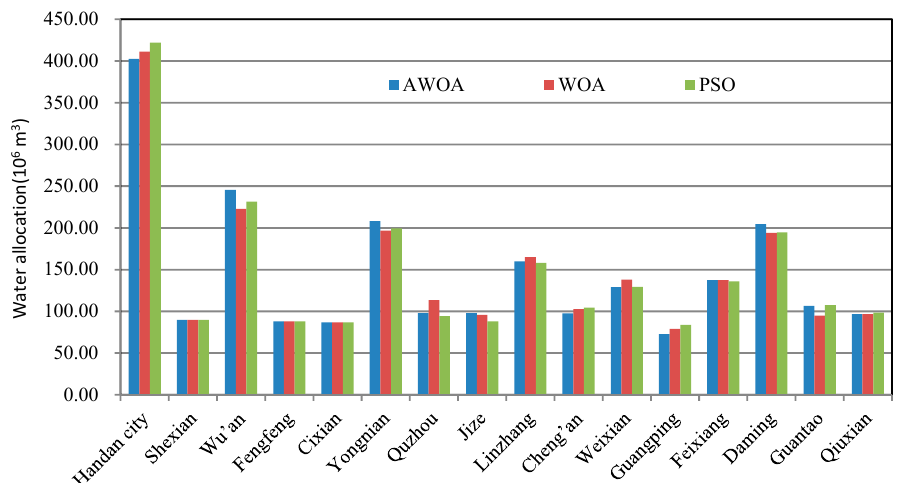
Water 2018 , 10 , 87 Figure 10. Water allocation based on three algorithms for each sub-region in Handan.